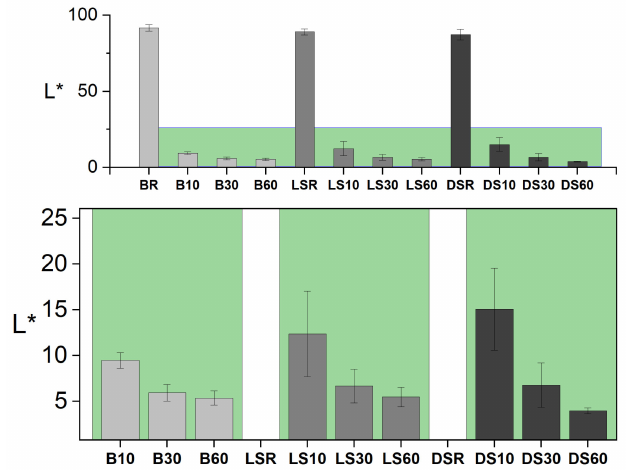
Figure 4. Lightness (L*) following modification. Inset (green area): modified